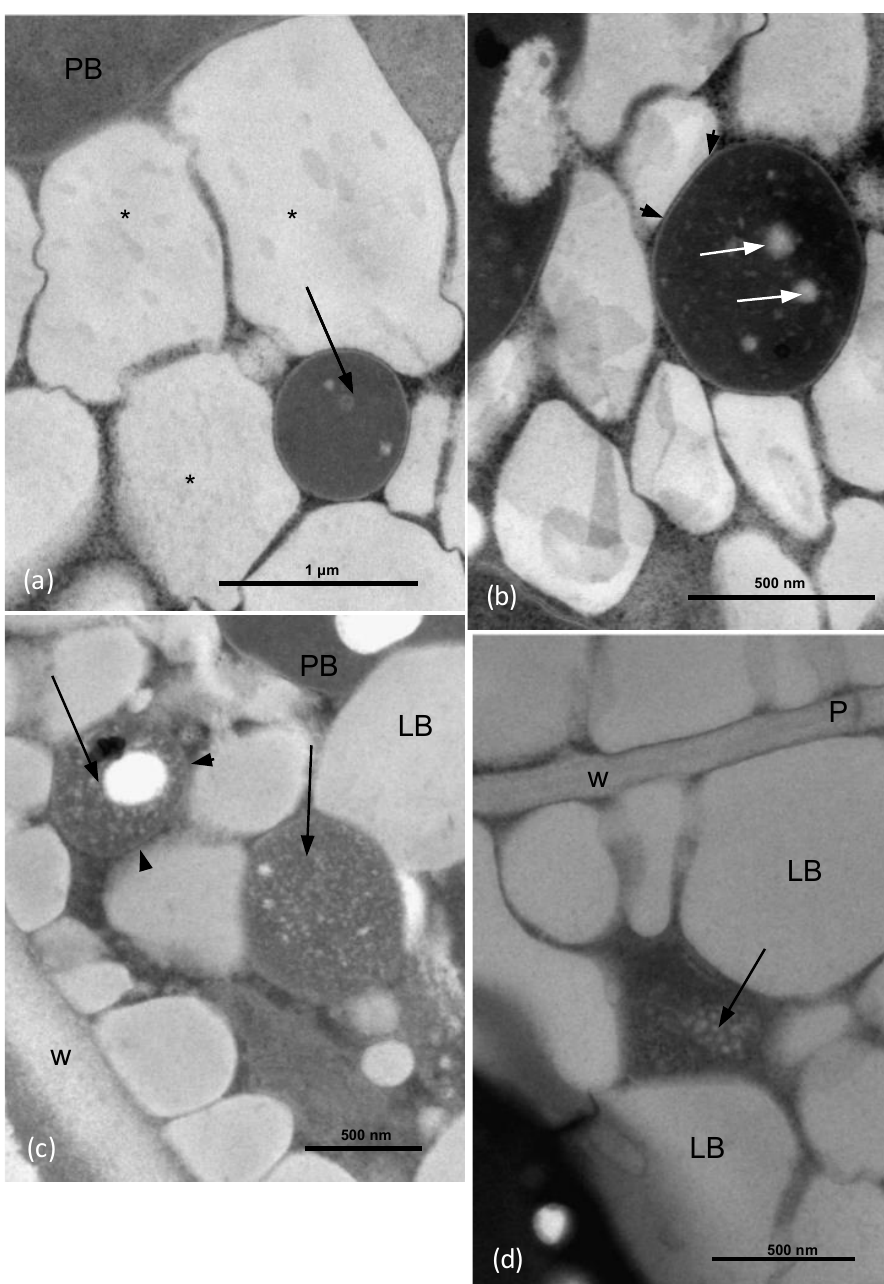
Figure 2. Transmission electron microscope sections of the O. heracleoticum seed. Cotyledon parenchyma cells close to the aleurone layer. ( a ) In the parenchyma cells, close to the aleurone layers, some roundish structures (arrow) about 700 nm in diameter on average, with electron-dense content, occupy a space among lipid bodies (asterisks). ( b ) The structures appear to be surrounded by a wall of about 15 nm (arrowheads). Inside, some electron-transparent globules (white arrows) stand out in the electron-dense background. ( c ) Close to the parenchyma cell wall, some roundish structures (arrows) of about 600 nm diameter show granular content and a wall of about 10 nm (arrowheads). ( d ) At some points among the lipid bodies, some elongated structures about 400 nm long, with granular content, did not enter via direct contact with the lipid bodies. No wall is present. LB = lipid body; P = plasmodesmata; PB = protein body; W = cell